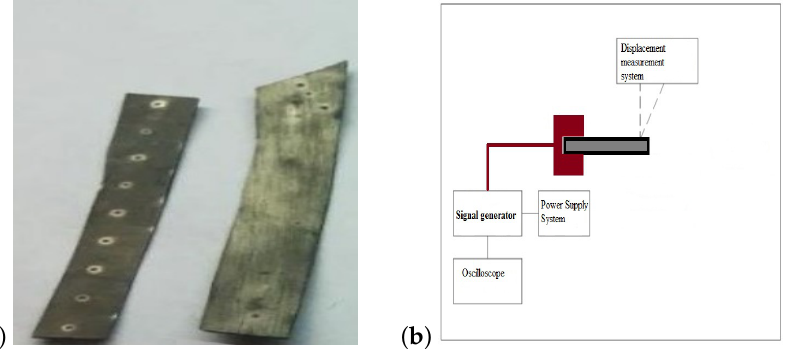
Figure 1. Tested electroactive polymers ( a ) and the test stand ( b